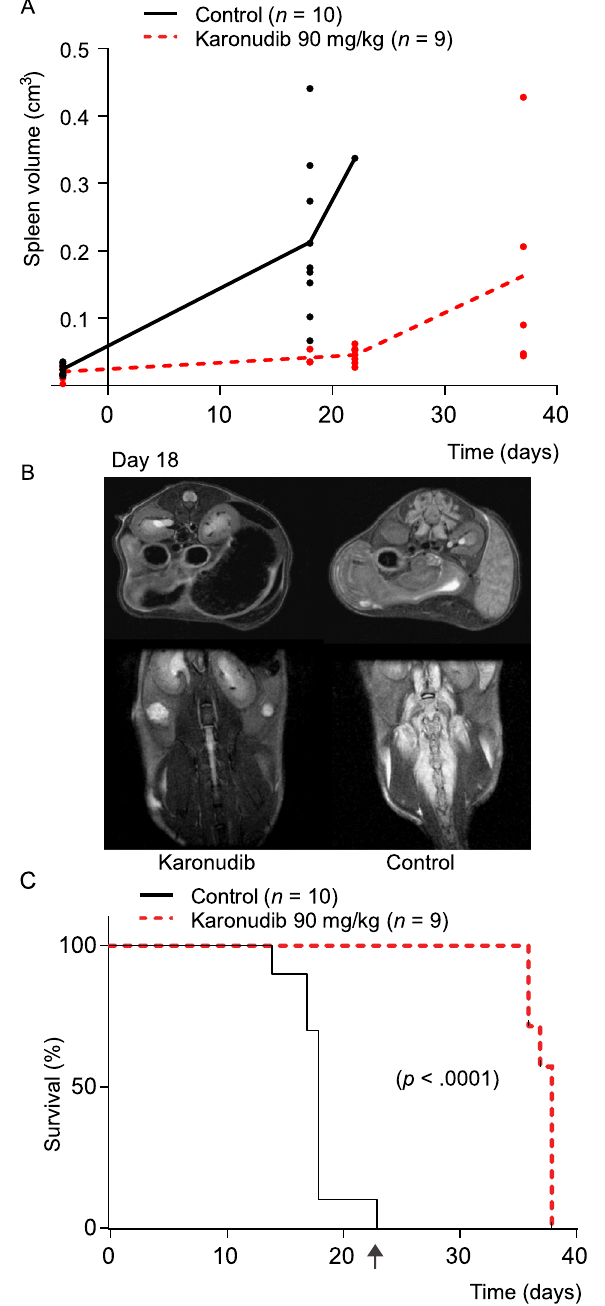
Figure 6. Karonudib has a strong anti-tumor effect in the ABC DLBCL PDX model DFBL-49659-V2. Tumor cells were injected intravenously and tumor growth monitoring of spleen and bone marrow with MR-imaging. ( A ) The treatment was initiated 12 days after tumor injection, and continued for 23 days as indicated (karonudib per os , b.i.d , 90 mg/kg three times a week). Spleen volume was measured by manual delineation on the T 2 - weighted images. First scan was performed 4 days prior to treatment start up. ( B ) T 2 -weighted MRI scans of a karonudib and vehicle treated mice at day 18. The arrows indicate increased spleen and edema around the spine in the untreated animal. ( C ) Median survival was 18 vs. 38 days in control vs. karonudib treated mice ( P < 0.0001, Log-rank test). The mice were monitored until they showed clinical signs. Arrow indicates end of treatment. All images are presented in Supplemental Fig.